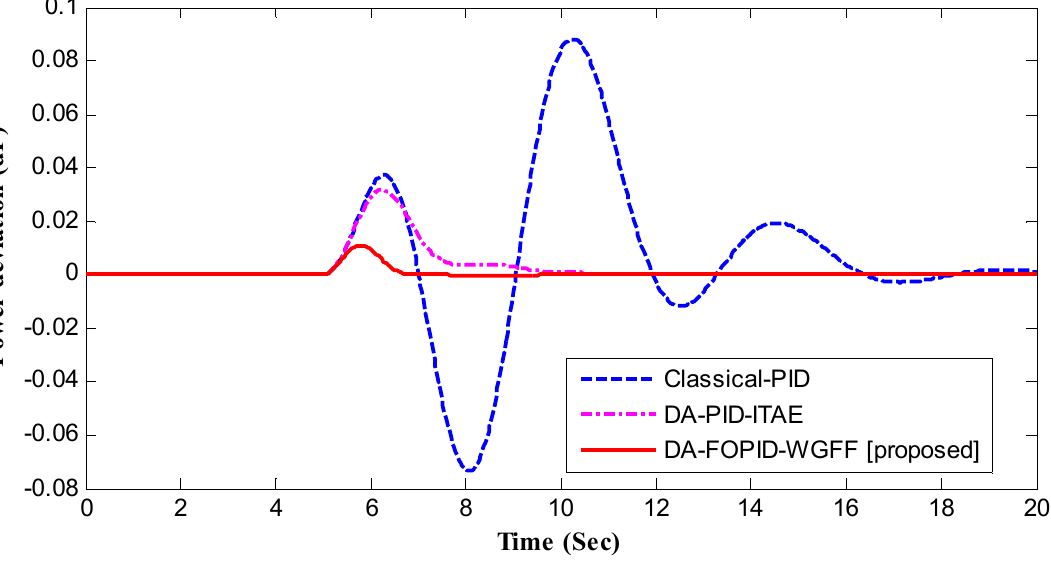
Figure 16. 𝜟𝒇 𝟐 using the proposed 2DOF-PID controller compared with other controllers. Figure 16. ∆ f 2 using the proposed 2DOF-PID controller compared with other controllers.